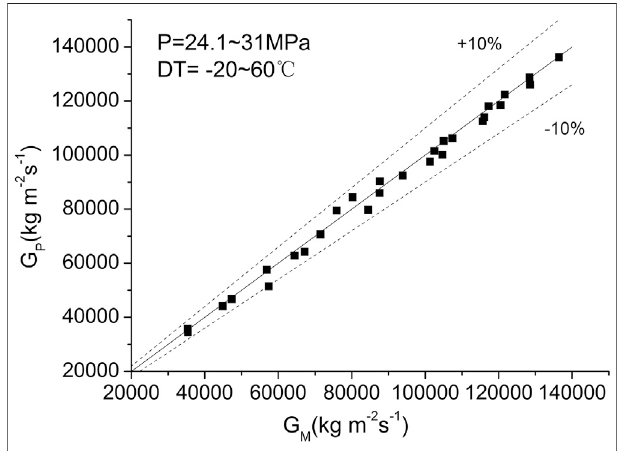
FIGURE 5 | Comparison to the result of Lee and Swinnerton.